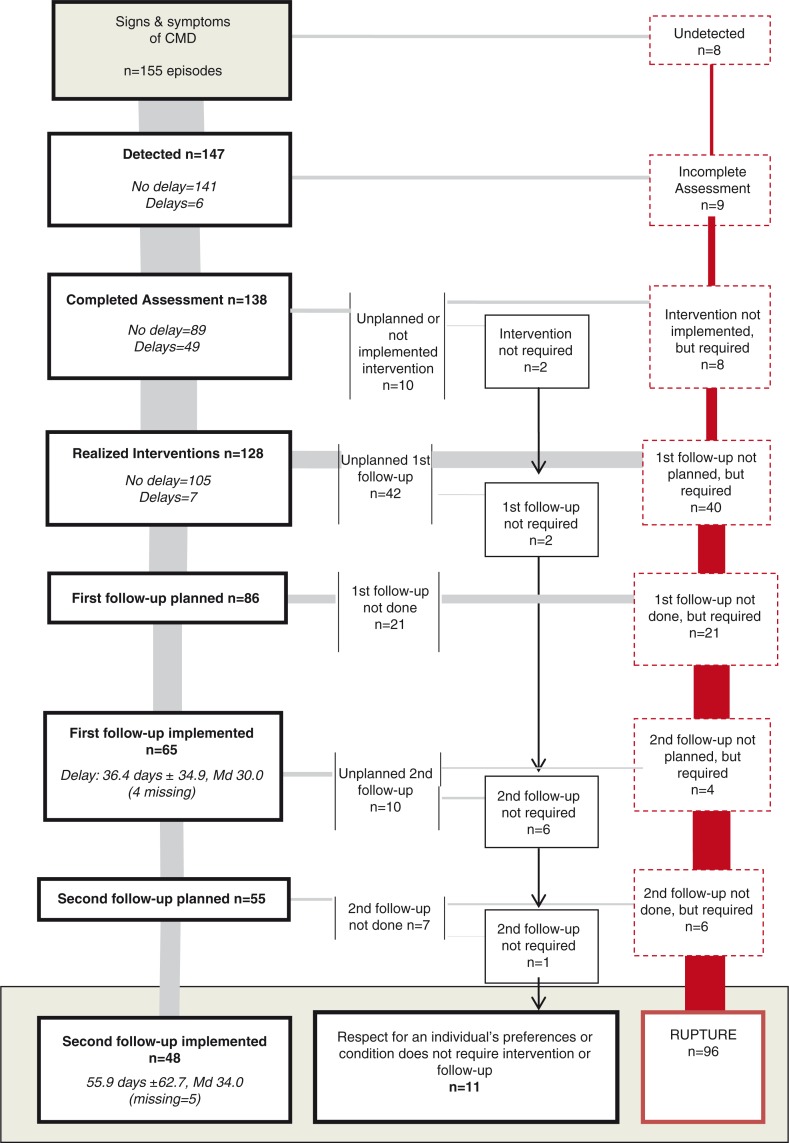
Continuum of care.